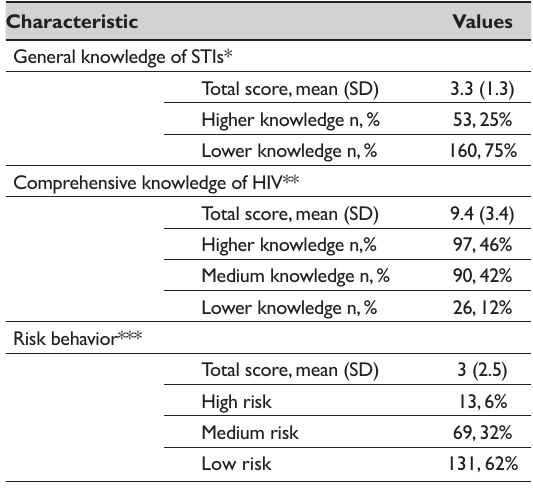
Table 2: Baseline characteristics of study population Characteristic